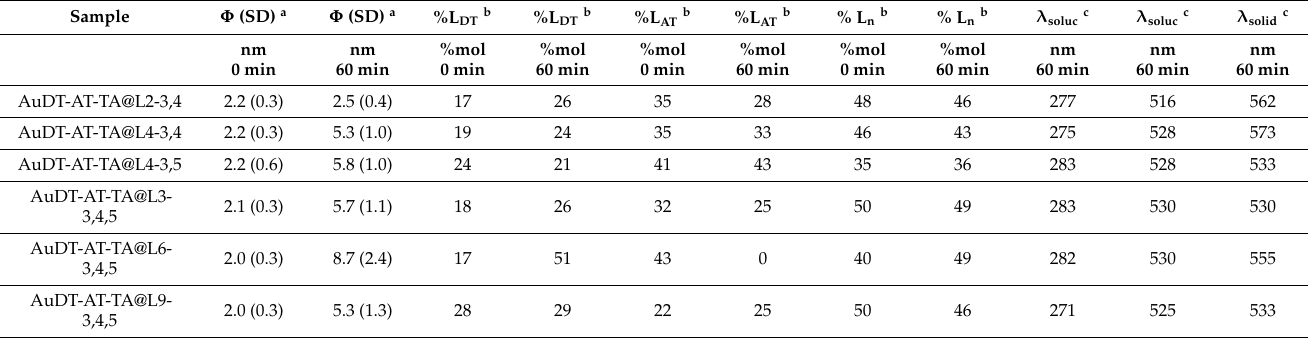
Table 3. Mean diameter (dispersion statistics), molar percentage of ligands and UV absorption